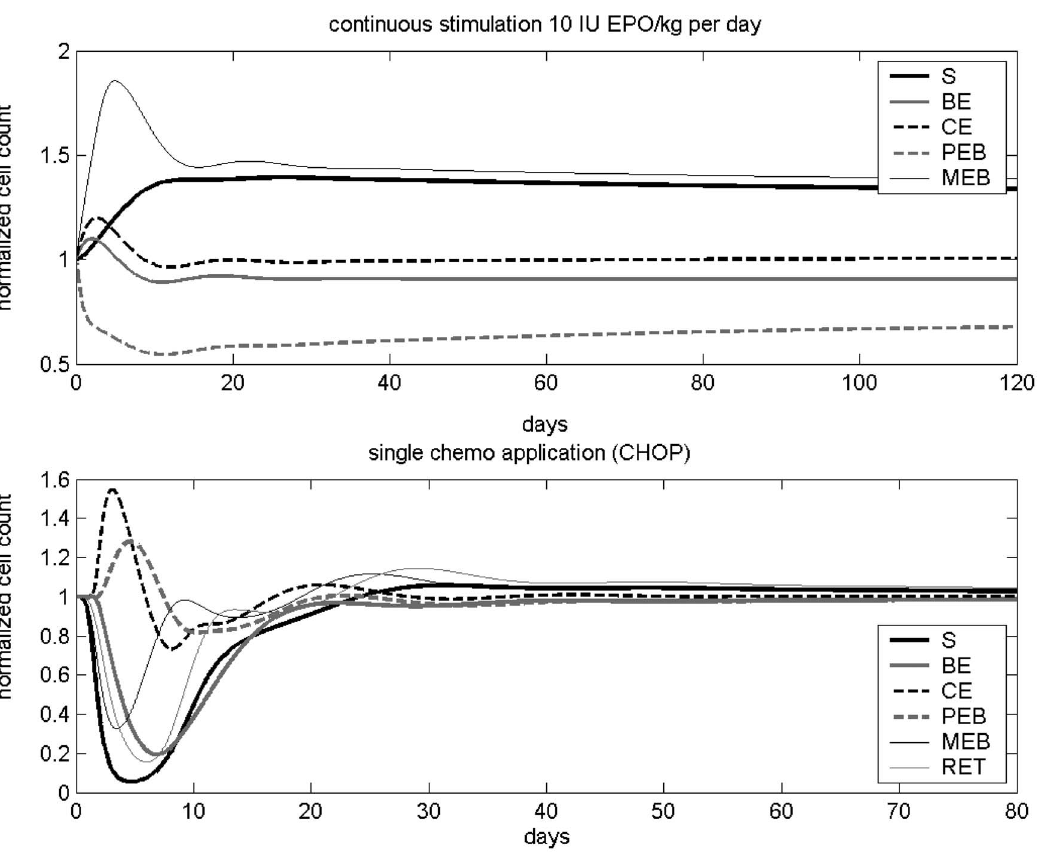
Figure 4. Model dynamics after single perturbations. A) Continuous EPO stimulation. B) Effect of a single cycle of CHOP chemotherapy.